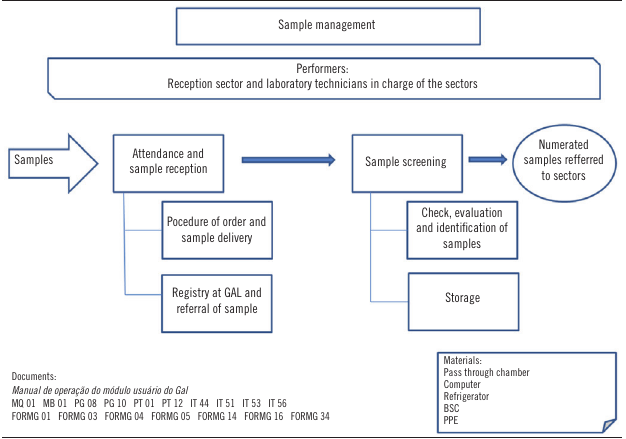
figurE 3 – Flow chart of sample management GAL: Gerenciador de Ambiente Laboratorial; BSC: biological safety cabinet; PPE: personal protection equipment.